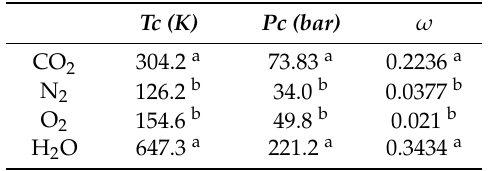
Table 1. Parameters of each component for PR